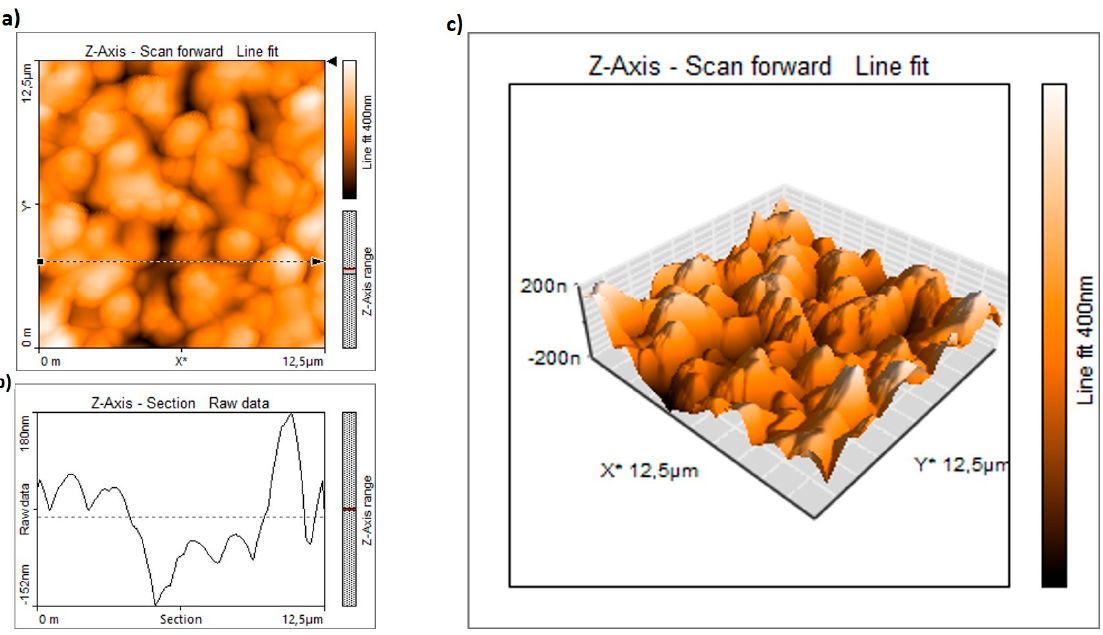
Figure 1. Atomic Force Microscopy image of the NiO/YSZ cermet surface performed on a 12.5 µm 2 . In ( a ) the image of the 2D surface topography is shown; in ( b ) the height profile measured along the line showed by the dashed arrow in ( a ) is presented; in ( c ) a 3D reconstruction of the surface topography showed in ( a ) is displayed. Estimated RMS surface roughness is Ry = 330 nm and Rq = 70 nm.